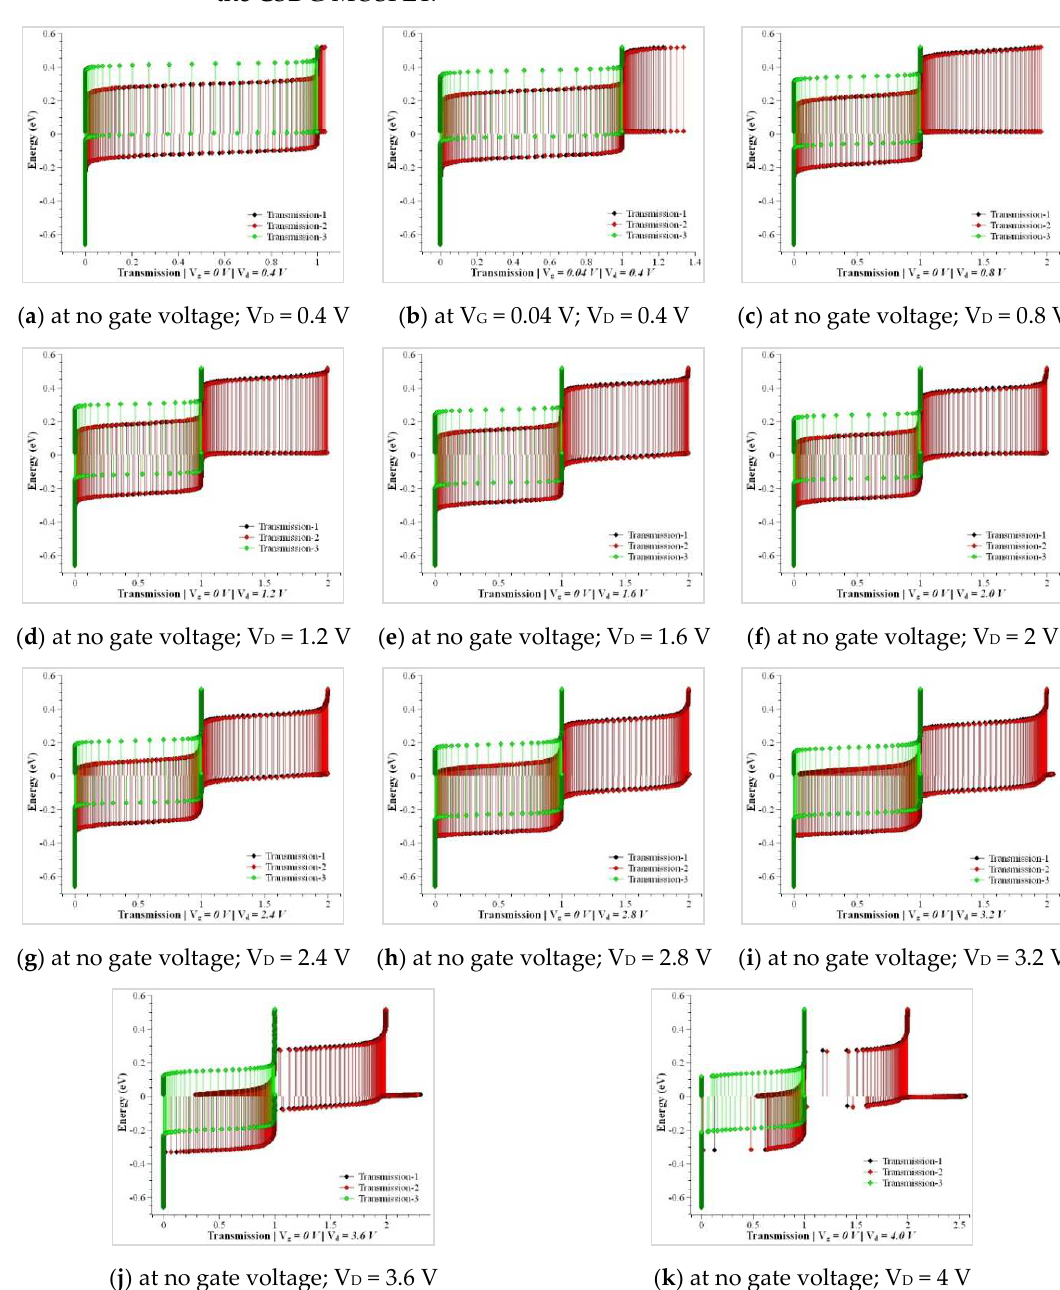
Figure 8. Transmission versus energy based on electron mobility.